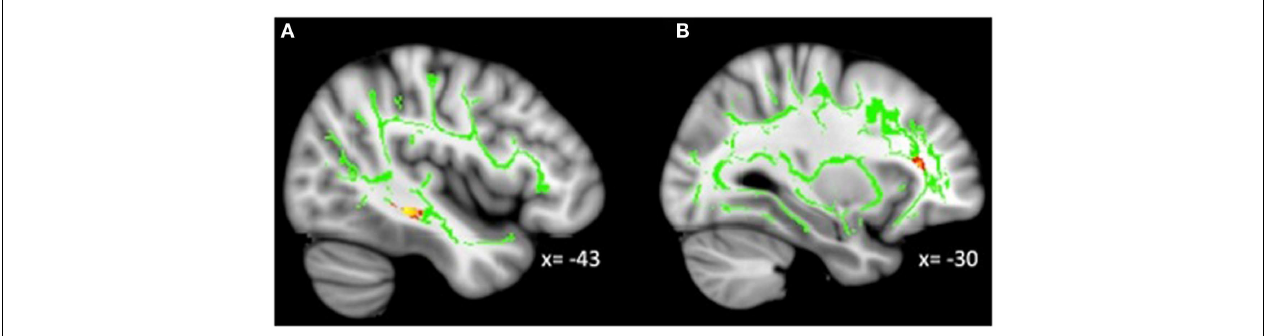
FIGURE 4 | DecreasedWM integrity as irritability increased in the (A) sagittal stratum in the IT; (B) IFOF near the MFG . Key: IT, inferior temporal cortex; IFOF, inferior-fronto-occipital fasciculus; MFG, medial frontal